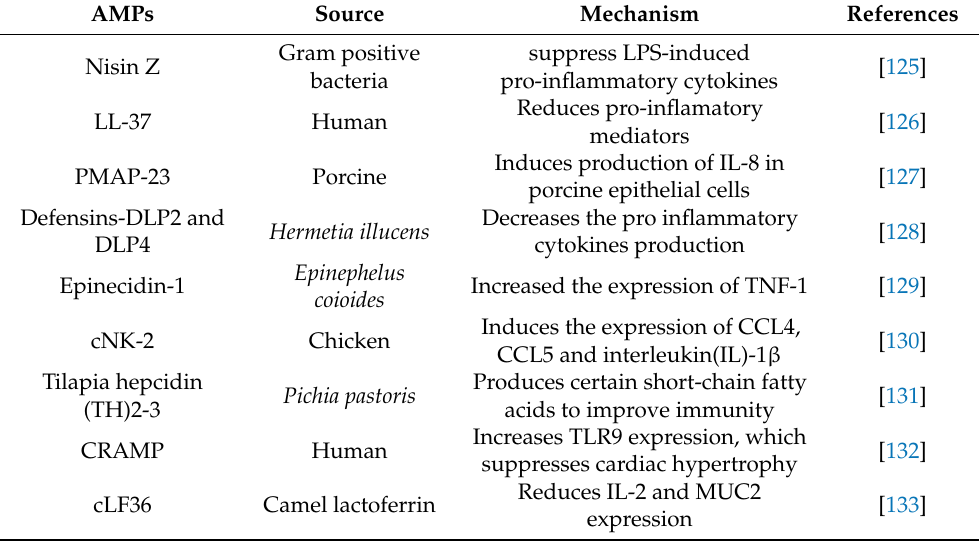
Table 6. List of some of the antimicrobial peptides suggesting an immunomodulatory effect. AMPs